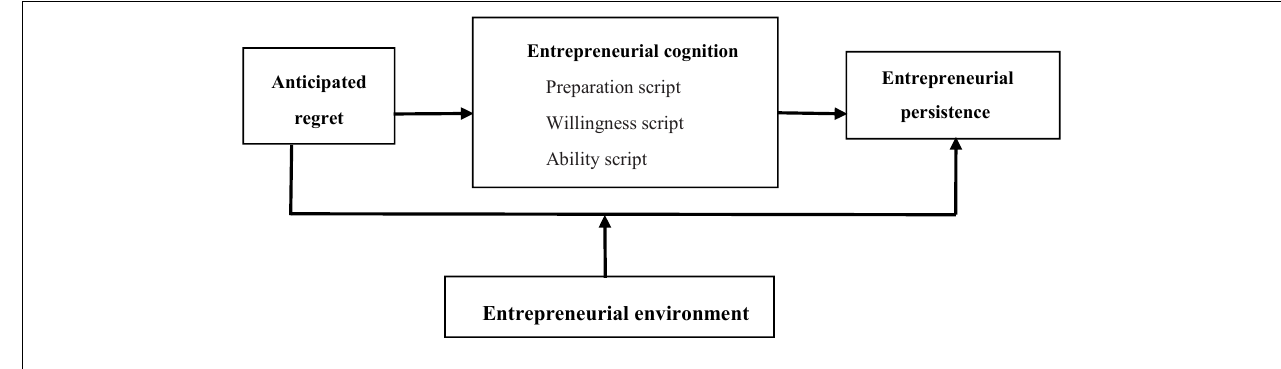
FIGURE 1 | Research